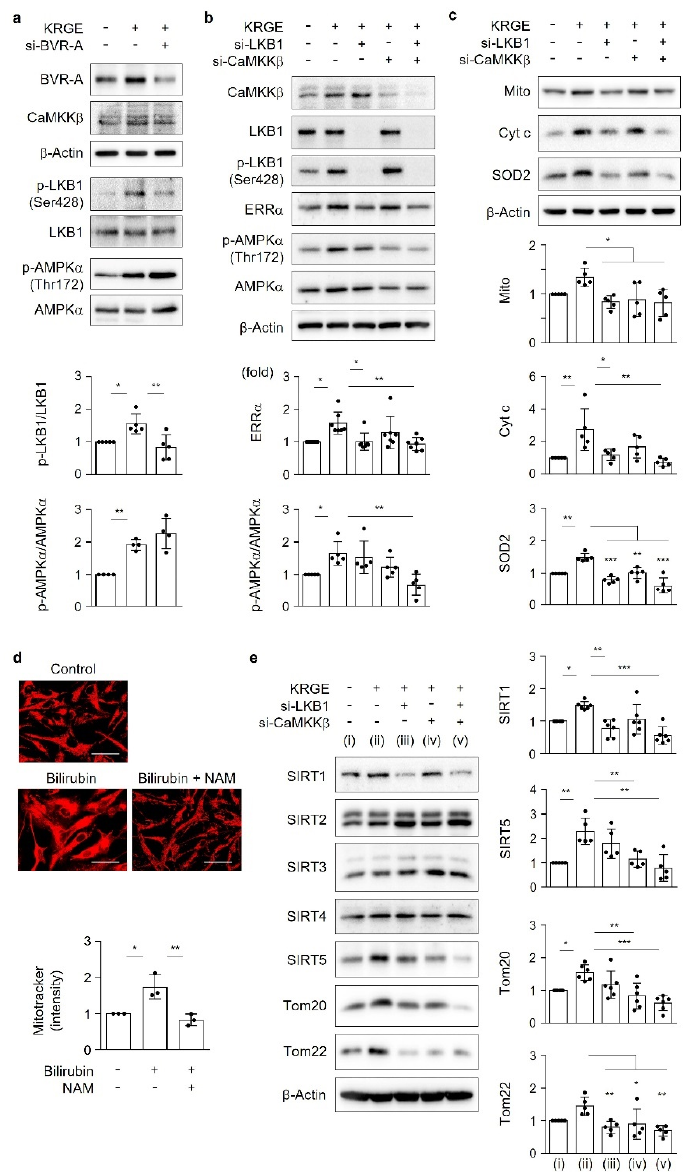
Figure 4. KRGE induces the LKB1-mediated expression of ERR α and mitochondrial functional proteins. ( a – c ) Astrocytes were transfected with control or target siRNAs and subjected to KRGE. Indicated protein levels were analyzed using Western blotting and quantified ( n = 4–6). ( d ) Astrocytes were incubated with 5 mM NAM for 30 min, followed by 50 µM bilirubin for 3.5 h and 0.5 µM MitoTracker-Red for 0.5 h. Live astrocyte cells were imaged using a confocal microscope ( n = 3). Scale bar = 25 µm. ( e ) Astrocytes were transfected with control or the indicated siRNAs, followed by 0.5 mg/mL KRGE treatment for 24 h. Target proteins were analyzed by Western blotting ( n = 5–6). (i) Water + control siRNA; (ii) KRGE + control siRNA; (iii) KRGE + si-LKB1; (iv) KRGE + si-CaMKK β ; (v) KRGE + si-LKB1 + si-CaMKK β . * p < 0.05; ** p < 0.01; *** p < 0.001. CaMKK β , Ca 2+ /calmodulin-dependent protein kinase kinase β ; NAM, nicotinamide.